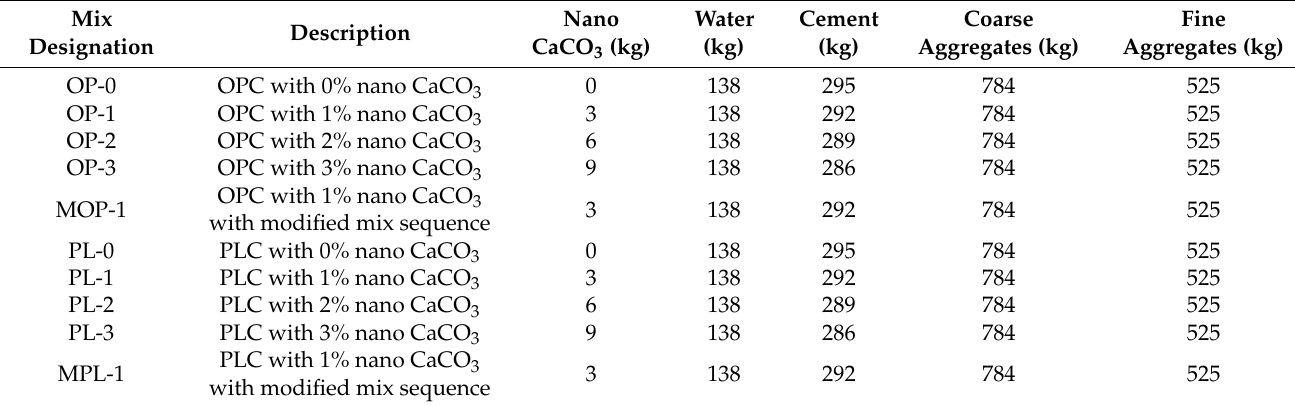
Table 2. Mix design for 0.76 m 3 (1 cy) of concrete. Mix designation consists of two parts: cement type (OP for OPC and PL for PLC) followed by a number which represents percentages of nano CaCO3 replaced: w/b ratio = 0.47 for all mixes, all units are in